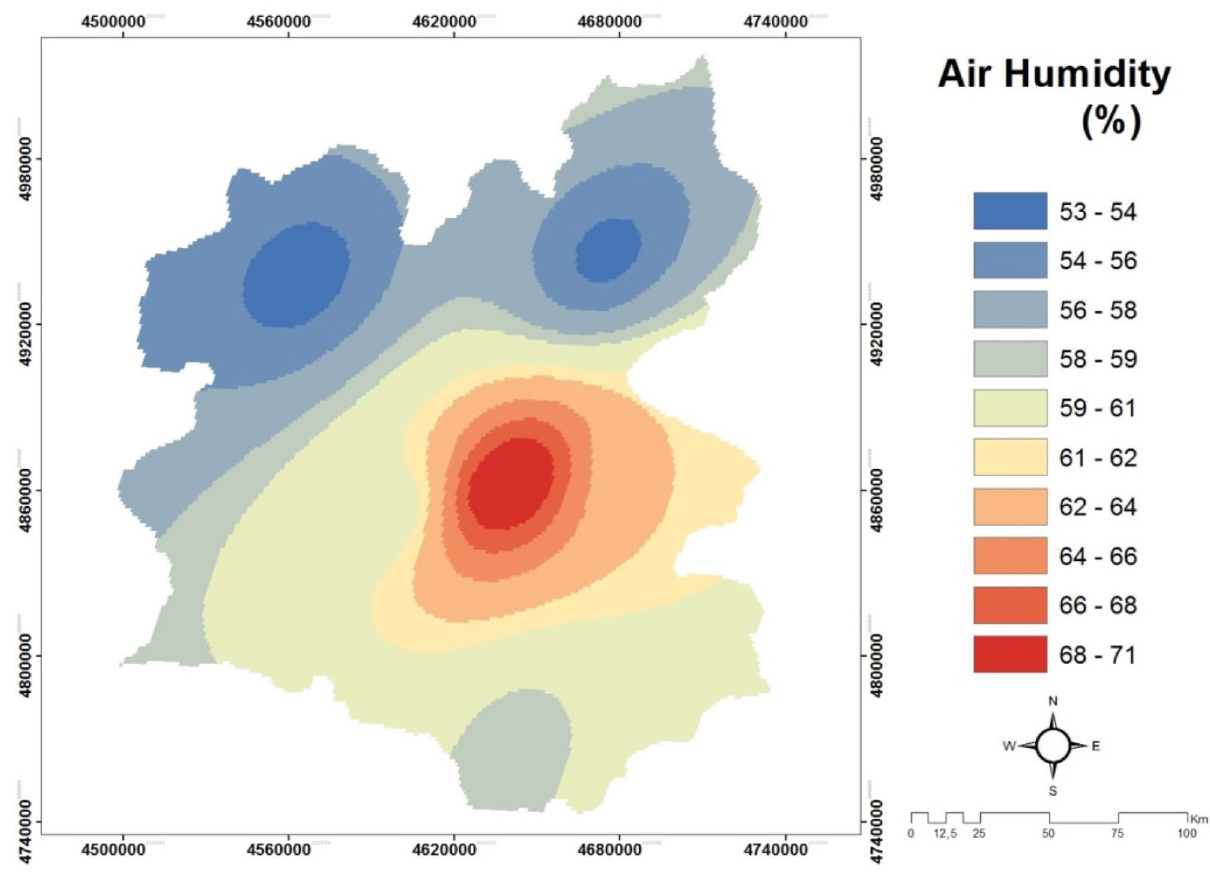
Figure 10. The air humidity map of Erzurum 20,50